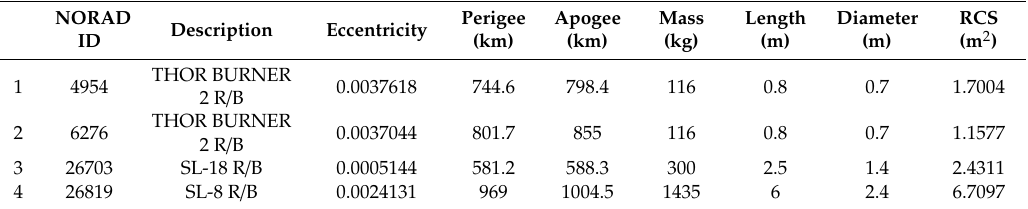
Table 4. The description of space debris targets in LEO.